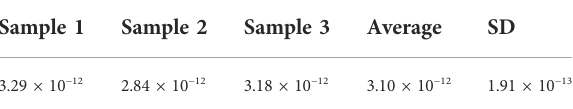
TABLE 4 The permeability of the endoneurium ECM RVEs computed using CFD